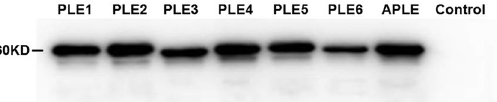
Figure 1. Detection of antibody cross-reactivity against PLEs. Seven recombinant PLEs were detected by western blotting. Control was a sample containing empty vector pET15b.